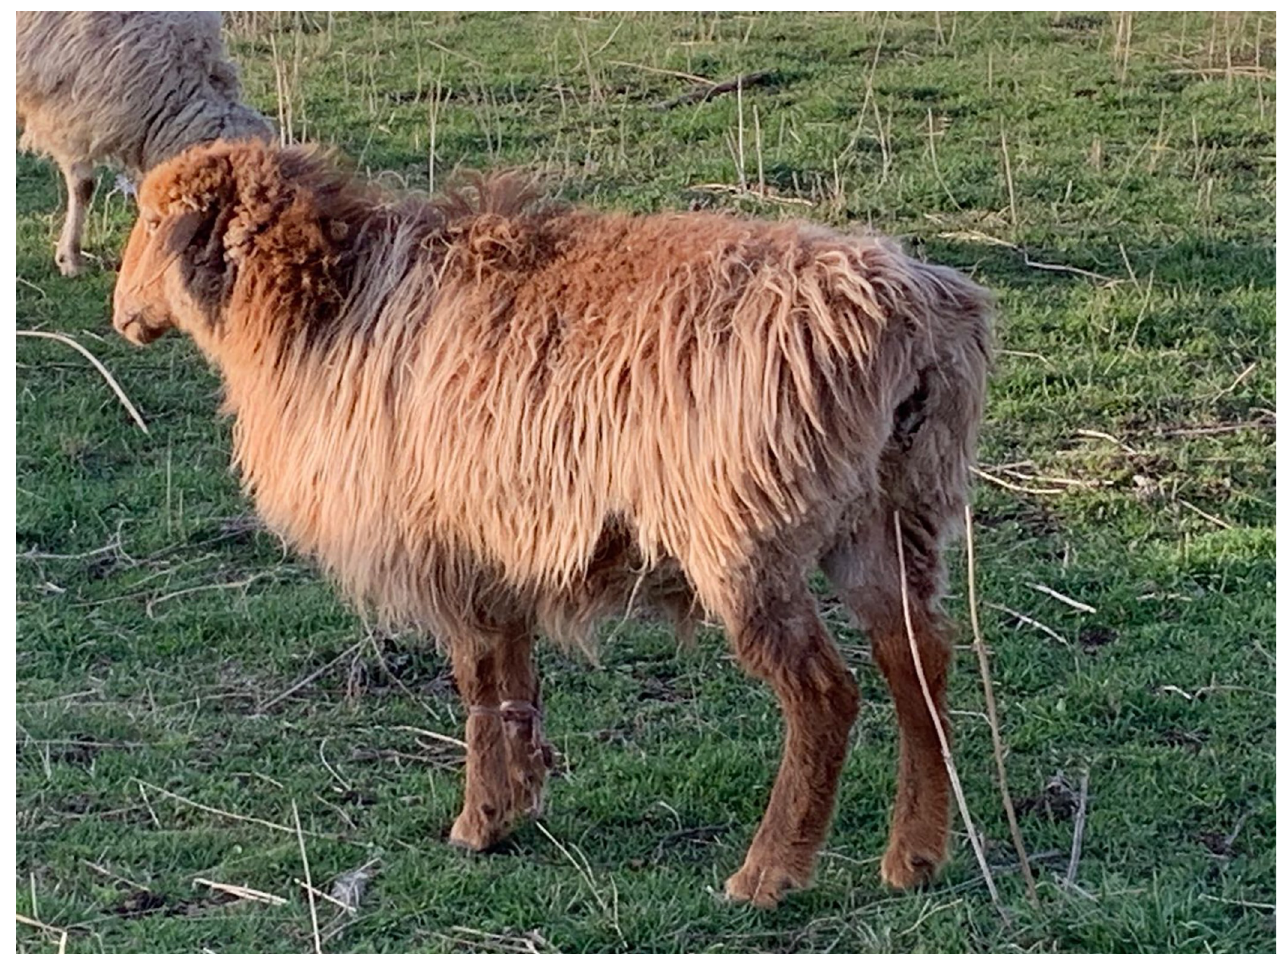
Fig 1. Kazakh ewe